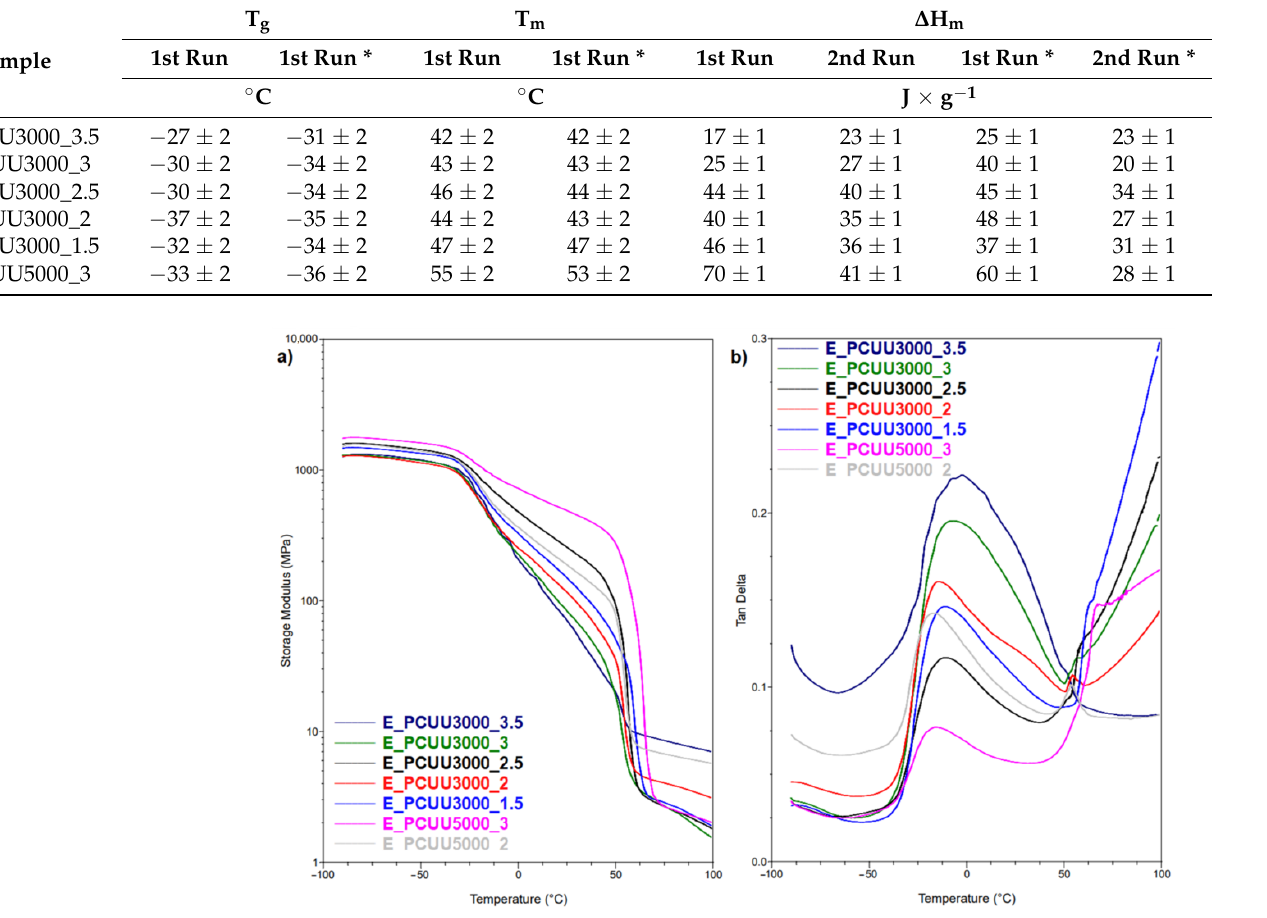
Figure 9. DMTA plots for ( a ) storage modulus and ( b ) Tan Delta as a function of temperature of PCUUs.